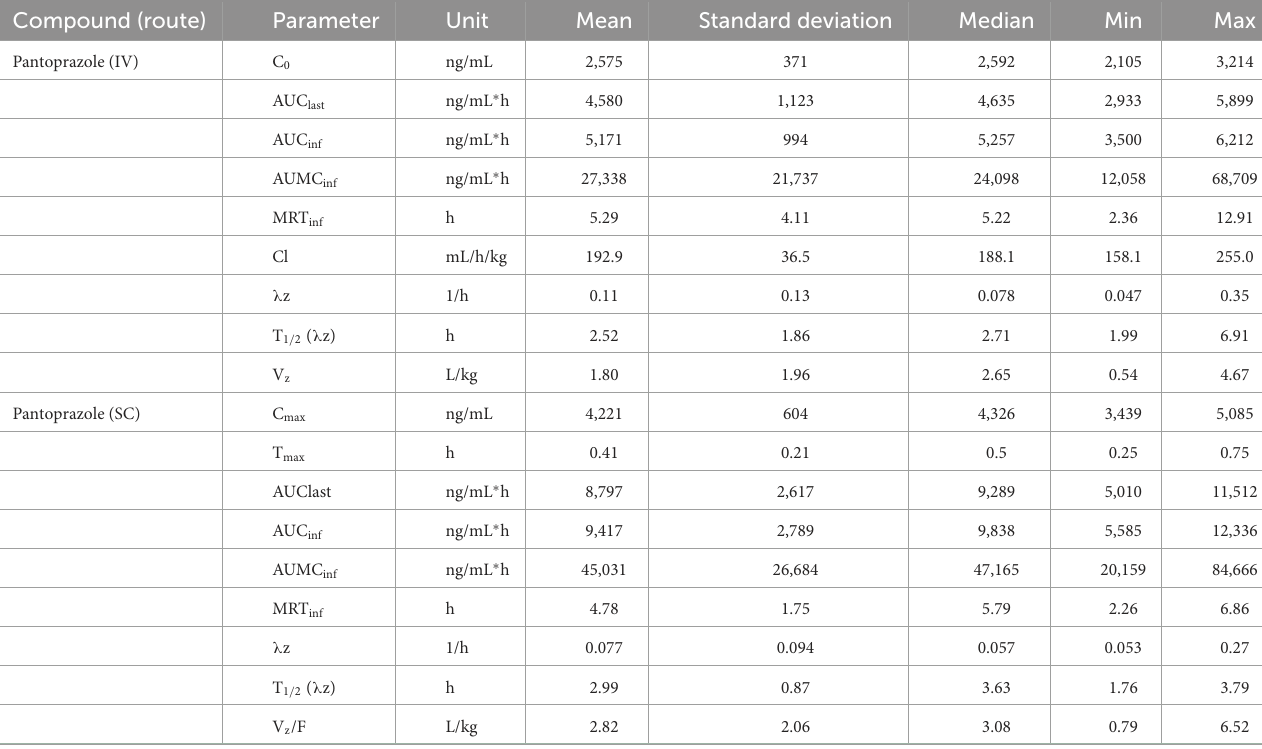
TABLE 2 Day 3 pharmacokinetic parameters of pantoprazole after intravenous (IV) and subcutaneous (SC) administration in calves. Compound